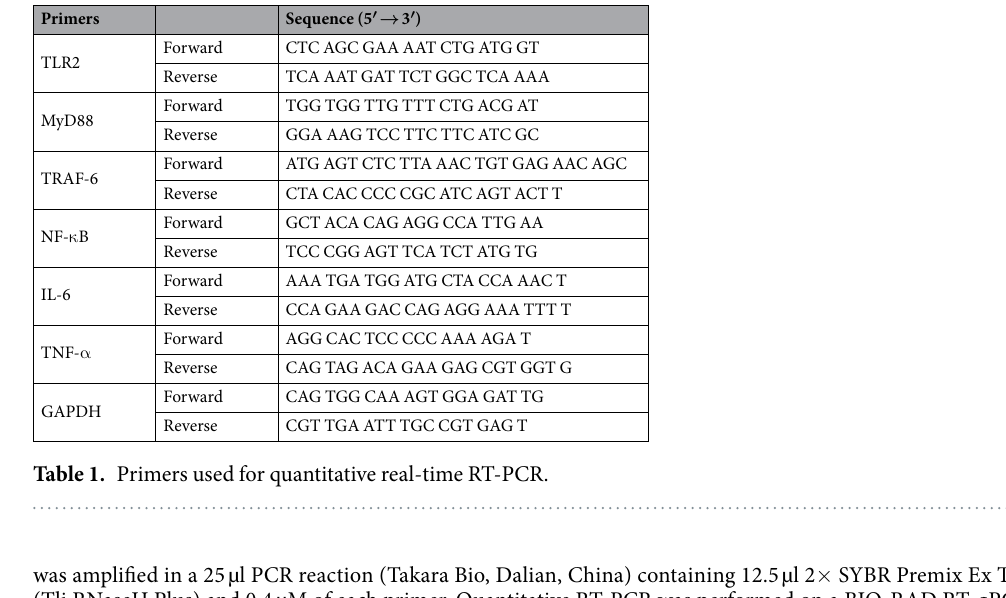
was amplified in a 25 µ l PCR reaction (Takara Bio, Dalian, China) containing 12.5 µ l 2 × SYBR Premix Ex Taq (Tli RNaseH Plus) and 0.4 µ M of each primer. Quantitative RT-PCR was performed on a BIO-RAD RT-qPCR system (iQ5 Optical Module, USA). After an initial denaturation at 95 °C for 30 sec, the samples were subjected to 40 amplification cycles of denaturation at 95 °C for 5 sec and annealing at 60 °C for 30 sec. After amplification, a melt curve analysis was performed. GAPDH was used as an internal control for sample loading and integrity. The details of the primers (Invitrogen, China) are listed in Table 1. All reactions were performed in triplicate, and tar- geted transcript levels were calculated and normalized to the transcript level of a housekeeping gene (GAPDH). Quantitative Real-time PCR results were calculated using the 2 − ∆∆ CT method as previously described 54 . Statistical analysis. Data were analyzed for statistical significance using SPSS 13.0 software. The data were expressed as the means ± standard deviations (SDs). Comparisons between groups were performed using the test of homogeneity of variances and one-way analysis of variance (ANOVA). Unpaired Student’s t-test was used for experiments comparing the WT and TLR2 − / − groups; p < 0.05 and p < 0.01 were considered statistically significant.